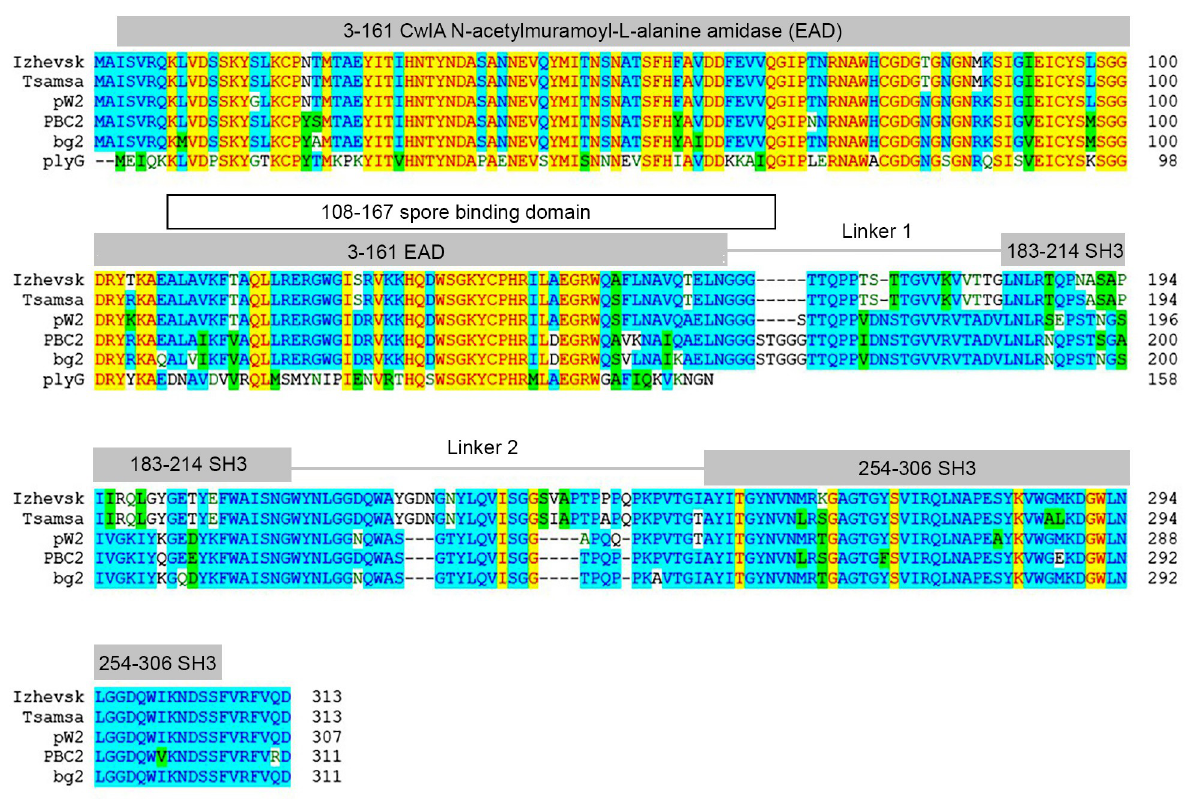
Fig 6. Multiple amino acid sequence alignment of Ply57 (ORF196) from bacteriophage Izhevsk with endolysins from vB_BanS-Tsamsa (YP_008873459.1), pW2 (AZU98917.1), PBC2 (AKQ08512.1), bg2 (ABX56142.1) and the enzymatically active domain of PlyG from Bacillus phage gamma (2L47_A). Conservative amino acids are highlighted in blue; amino acids matching the residues of the PlyG endolysin are yellow; synonymous substitutions are green. Conservative domain regions revealed with DELTA-BLAST are indicated above the aligned sequences.